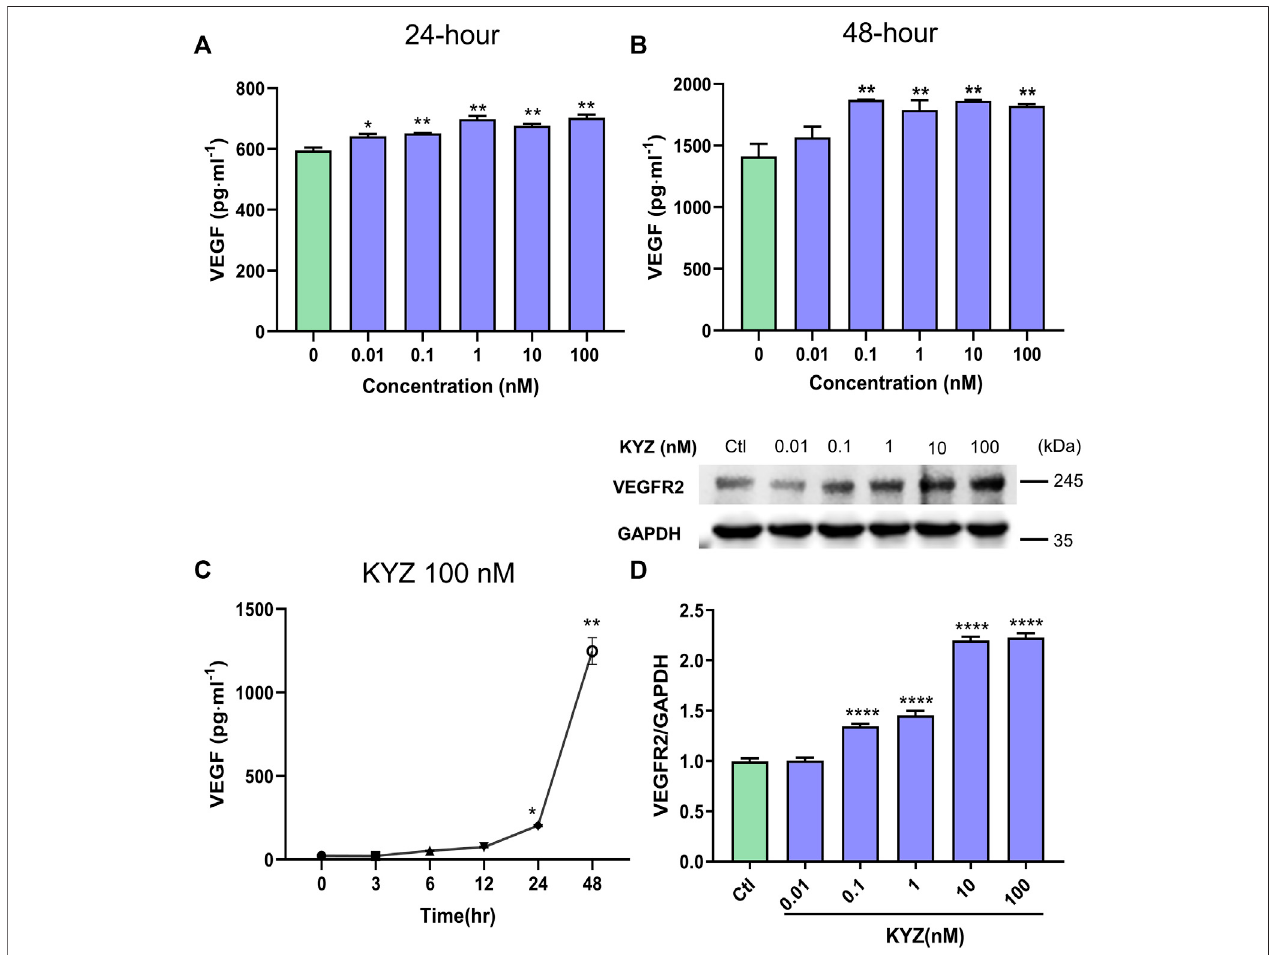
FIGURE8| KYZtreatmentincreasedtheVEGFsecretionandVEGFR2expressioninHUVECs. (A – B) HUVECswereculturedin6-wellmicroplate andweretreated withdifferentconcentrationsKYZfor48 h,thetotalvolumeofculturemediumwas5 ml.50 µlculturemediumwascollectedat24and48 h,respectively.VEGFlevelwas analysed by ELISA assay. (C) the HUVECs were treated with KYZ (100 nM) for 3, 6, 12, 24, 48 h, then the medium was collected and was analysed for VEGF secretion level by ELISA (D) the VEGFR2 expression was determined by western blotting and gray value of the result was analysed by ImageJ software. The data were expressed as mean ± SEM ( n = 3). One-way ANOVA was used for statistical analysis. * p < 0.05,** p < 0.01,*** p < 0.001,**** p < 0.0001 vs